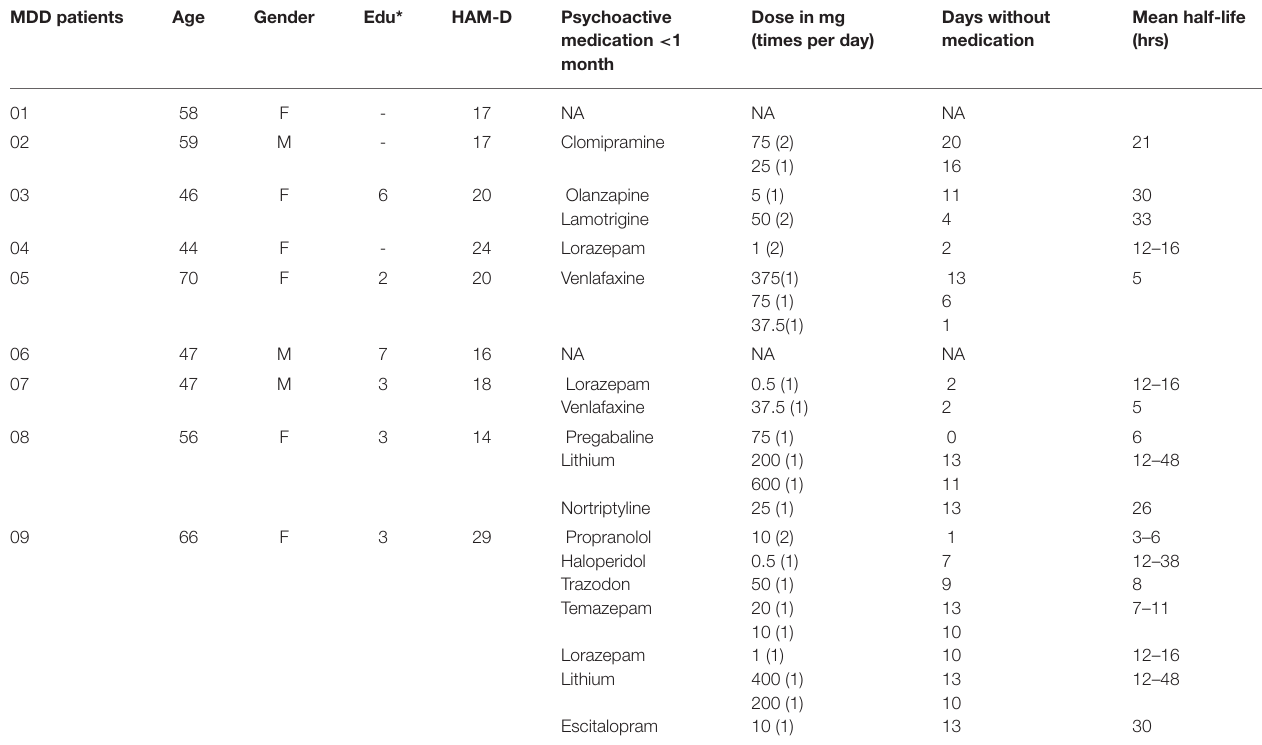
TABLE 1 | Characteristics of MDD patients. MDD